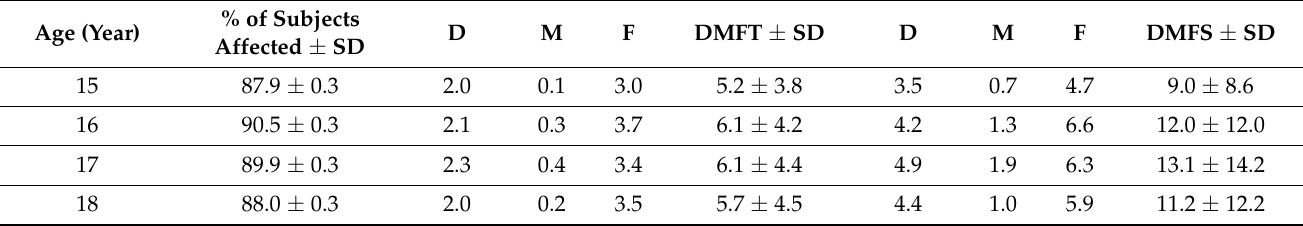
Table 3 shows that the mean decayed, missing, and filled teeth (DMFT) scores for ages 15 to 18 were 5.2, 6.1, 6.1, and 5.7. The corresponding decayed, missing, and filled surfaces (DMFS) scores were 9.0, 12.0, 13.1, and 11.2 for ages 15 to 18. The prevalence of dental caries seemed to increase with age, reaching a peak at 16 years of age. Table 3. Dental caries prevalence, mean DMFT, and mean DMFS scores among Taiwanese students aged 15–18 years. Age